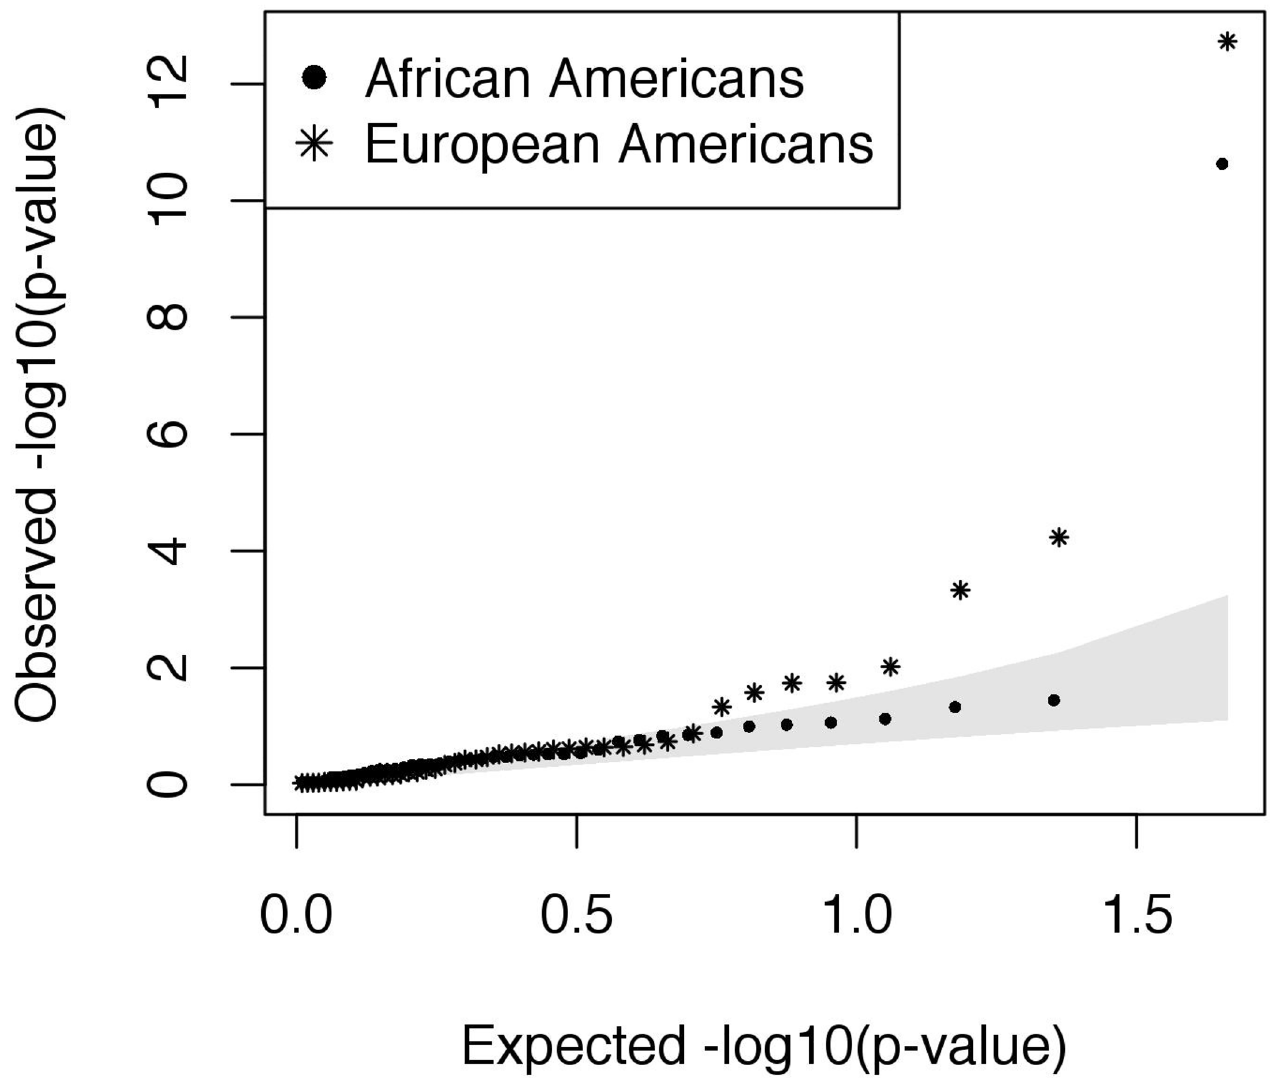
Fig 1. Iceberg plot showing how the majority of coding variants identified per gene are at minor allele frequencies (MAF) at or below 10% in both European American (EA, N = 39) and African American (AA, N = 49) asthma cases and controls following severe RSV bronchiolitis in infancy. A total of 131 asthma genes were sequenced; each vertical bar represents a gene with at least one coding variant detected in the sample.